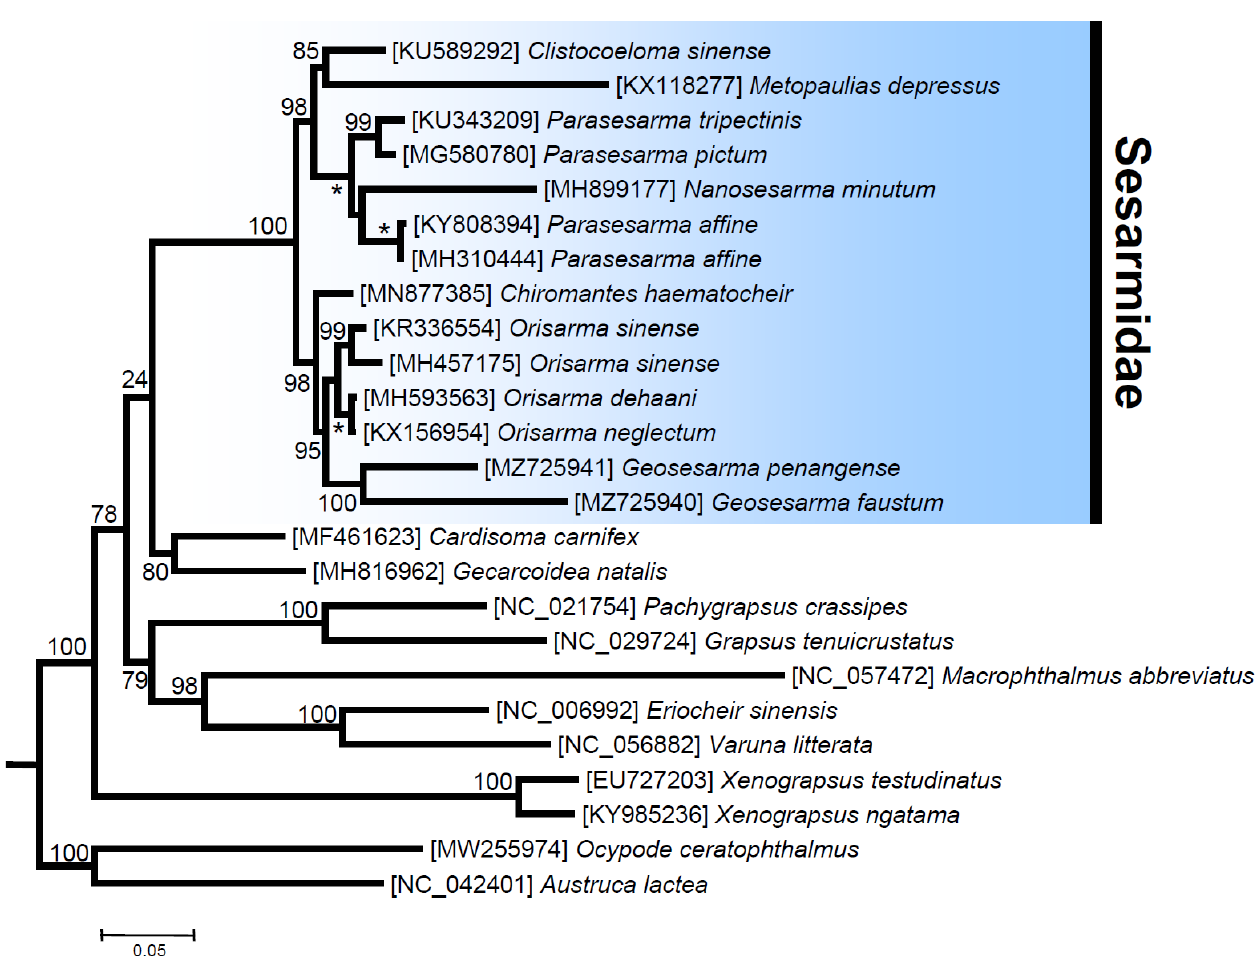
Figure 5. Total evidence phylogenetic tree obtained from ML analysis based on a concatenated alignment of amino acids of the 13 protein-coding genes present in the mitochondrial genome of Metopaulias depressus and other representatives of the family Sesarmidae. Outgroups included a total of four species belonging to the families Gecarcinidae and Xenograpsidae. The robustness of the ML tree topology was ascertained by 1000 bootstrap pseudoreplicates (numbers above or below the nodes) of the tree search. *: full support, boostrap value = 100.